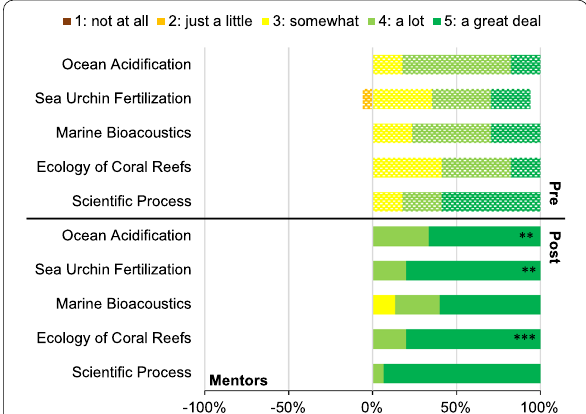
Fig. 9 Competence: Pre- and post-program mentor science knowledge competence. Responses to competence REMS survey items of perceived understanding (1 relating to five (5) program modules from Mentors ( N the 2016–2018 REMS programs. Differences in pre–post scores